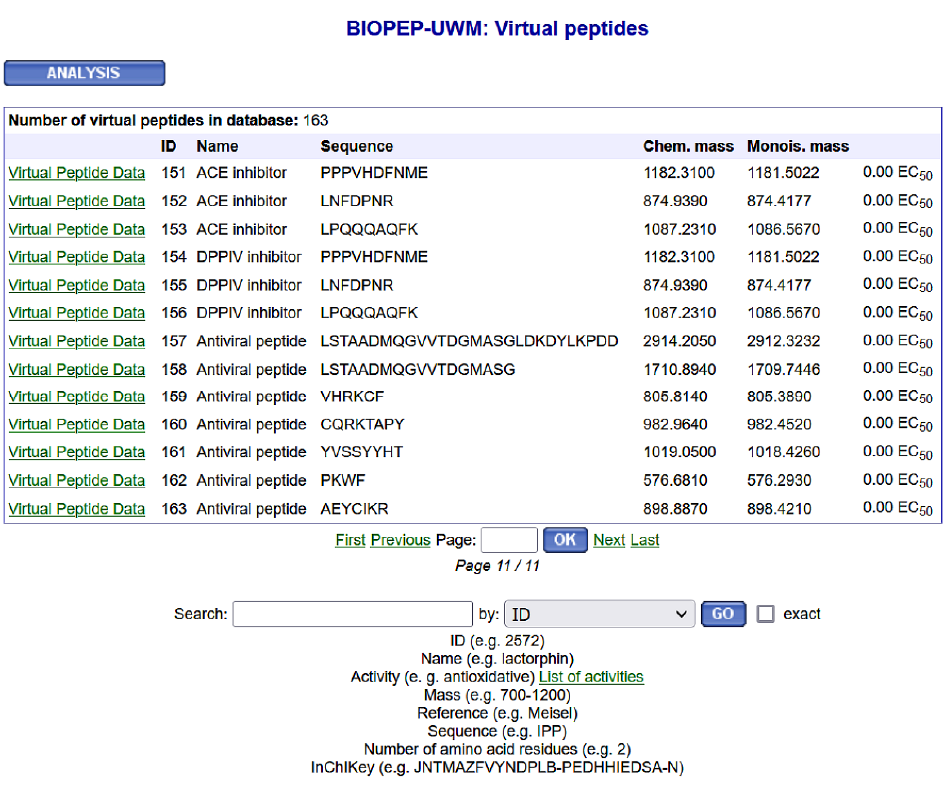
Figure 2. Scheme of the organization of the BIOPEP-UWM Virtual database. Due to the fact that the layout of the new database is identical to the BIOPEP-UWM database of bioactive peptides described in our previous article [12], the Figure is adapted from the above reference.